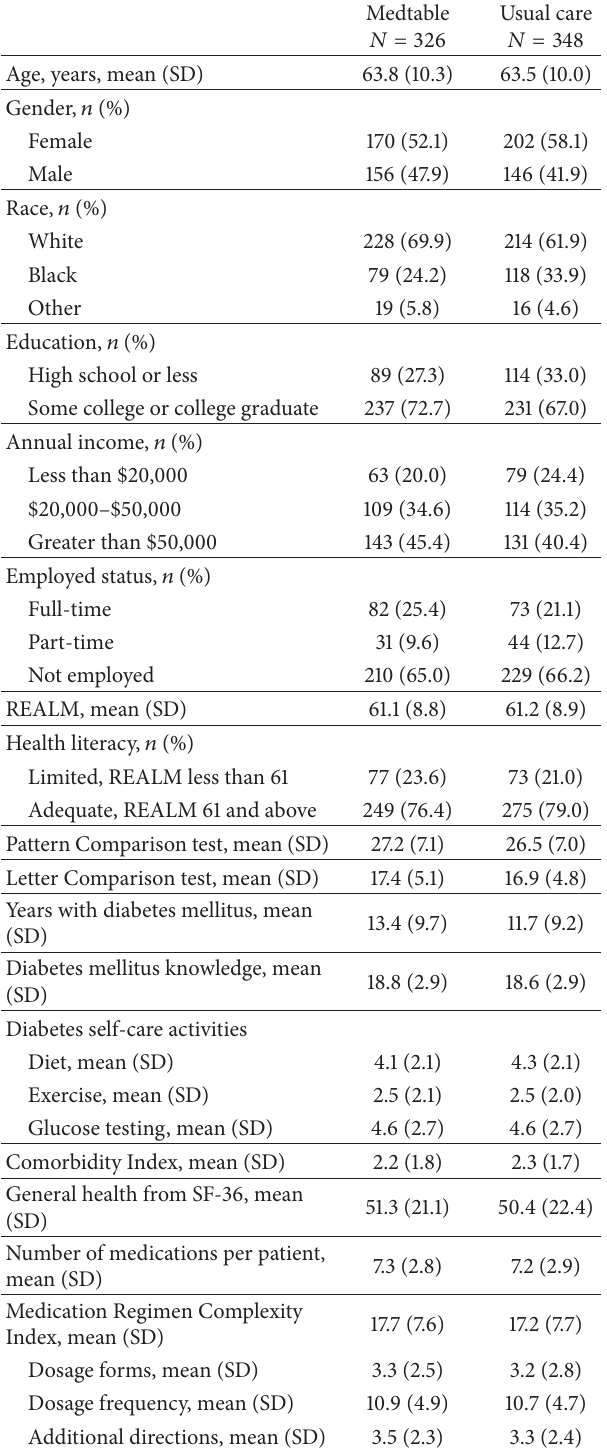
Table 1: Baseline characteristics of 674 outpatients allocated to Medtable or usual